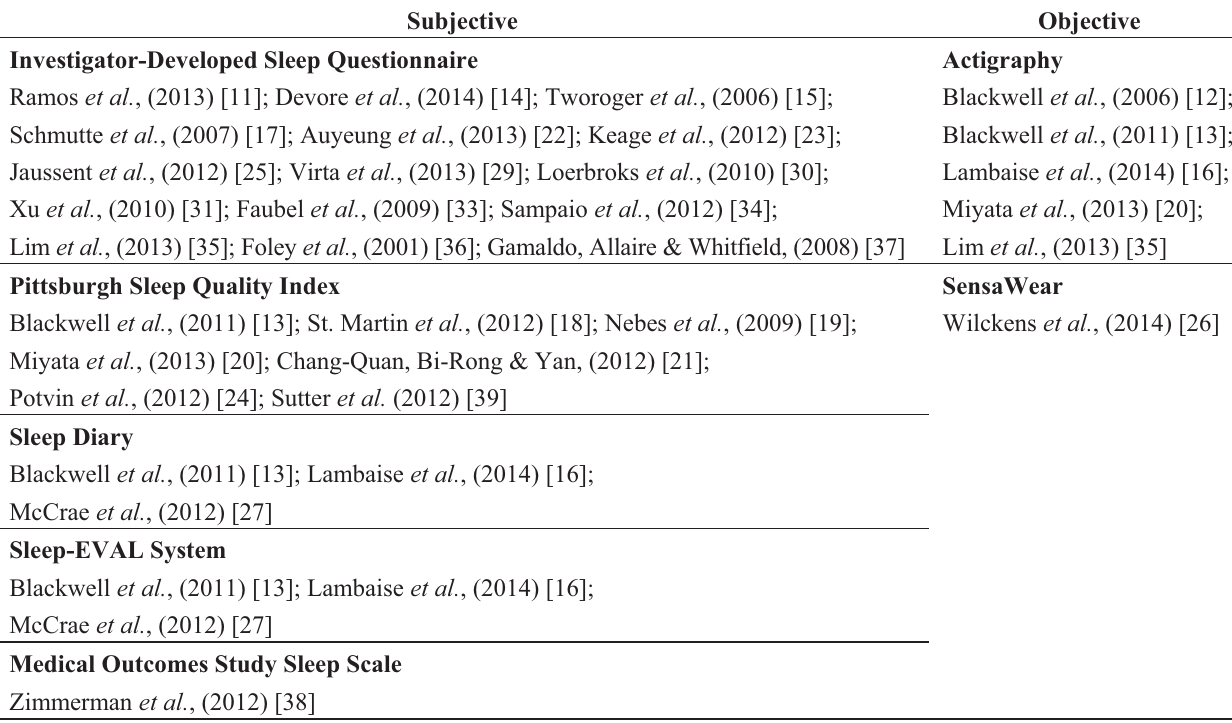
Table 2. Table displaying the measures used to assess